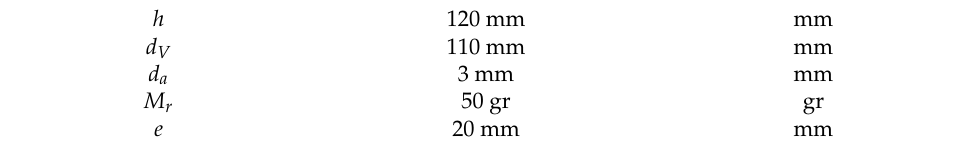
Figure 2. Vibrodyne scheme. Table 2. Vibrodyne dimensions.